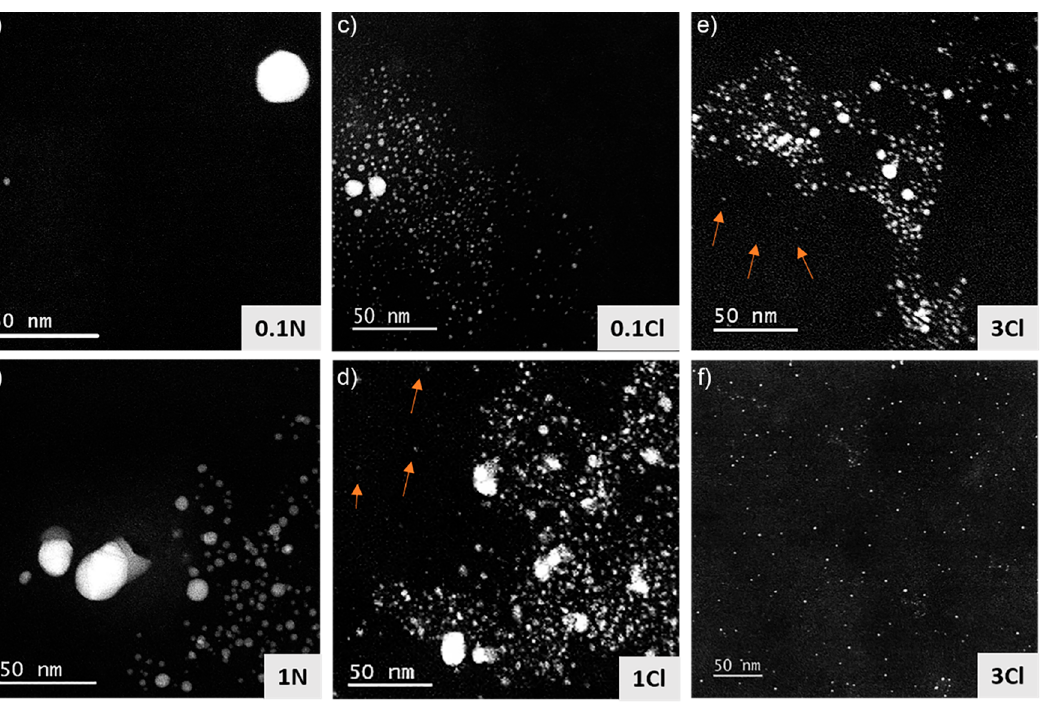
Figure 3. HAADF-STEM images of 3D printed structures containing acrylic resin and different concentrations of silver precursor. ( a ) 0.1N; ( b ) 1N; ( c ) 0.1Cl; ( d ) 1Cl; ( e ) 3Cl; ( f ) 3Cl (different area).